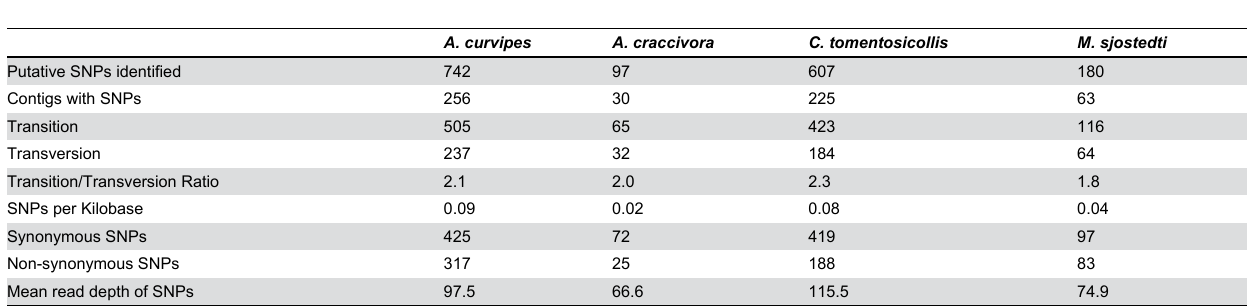
Table 1. Statistics from Roche 454 sequencing of A. curvipes , A. craccivora , C. tomentosicollis and M. sjostedti cDNA libraries generated from pools of all tissues and the larval and adult life